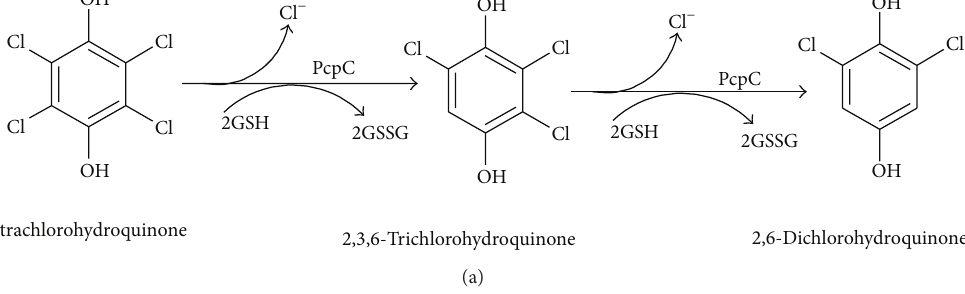
consists of a peptide of 343 amino acids [15]. Comparison of the genome of UT-26 with those of Sphingomonas